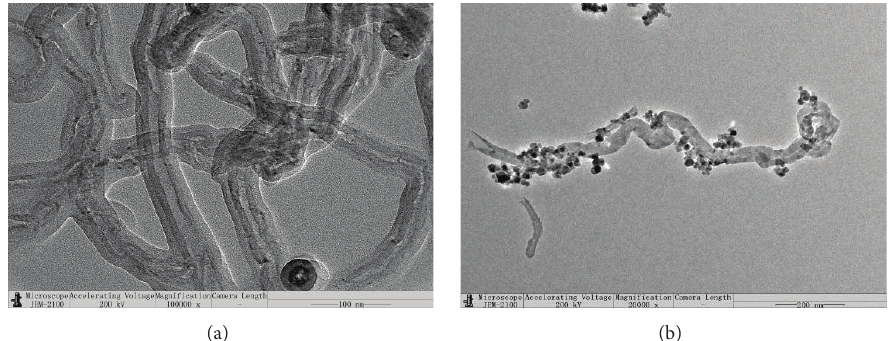
Figure 2: TEM images of O-MWNTs and Fe 3 O 4 /MWNTs: (a) O-MWNTs and (b) Fe 3 O 4 /MWNTs.